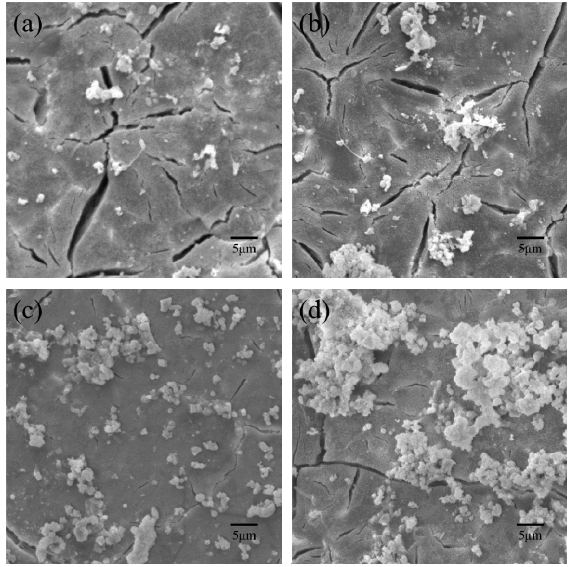
Figure 8. Surface morphologies of the PHBV/10%CS composite scaffolds after immersing in SBF for ( a ) 7, ( b ) 14, ( c ) 21, and ( d ) 28 days.